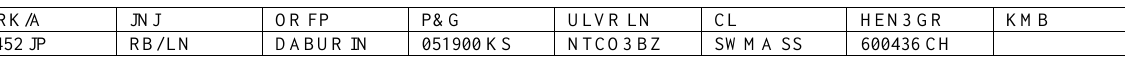
Table A1: BBT Firms used in the